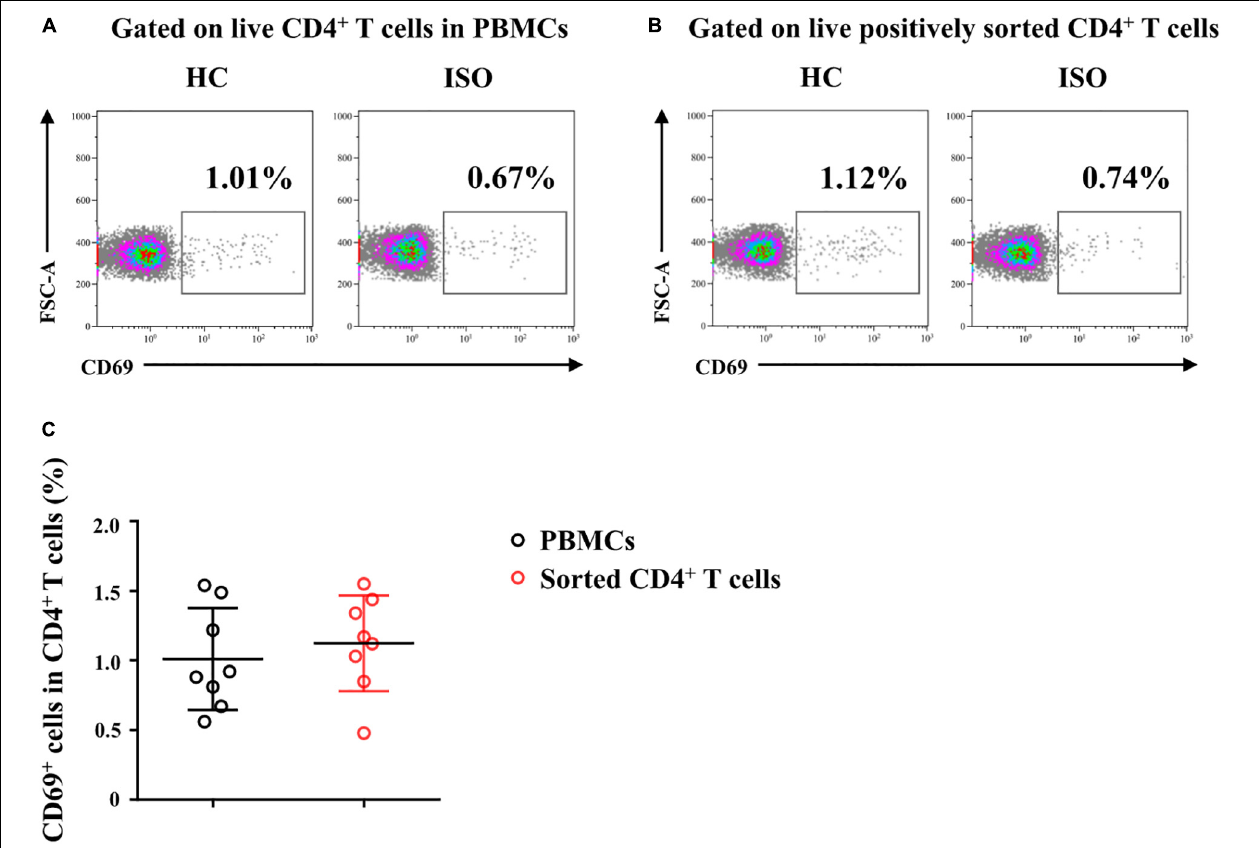
FIGURE 4 | Freshly sorted CD4 + T cells from HC subjects were not activated. (A,B) Representative flow plots of CD69 expression on CD4 + T cells in peripheral blood mononuclear cells (PBMCs) and on freshly positively sorted CD4 + T cells from HC subjects ( n = 8). (C) Quantification of percentages of CD69 + cells in CD4 + T cells in PBMCs and in sorted CD4 + T cells. Data were tested for normality using the Shapiro–Wilk test, and expressed as means ± SD according to normality test results. Significant difference was tested using paired t -test between